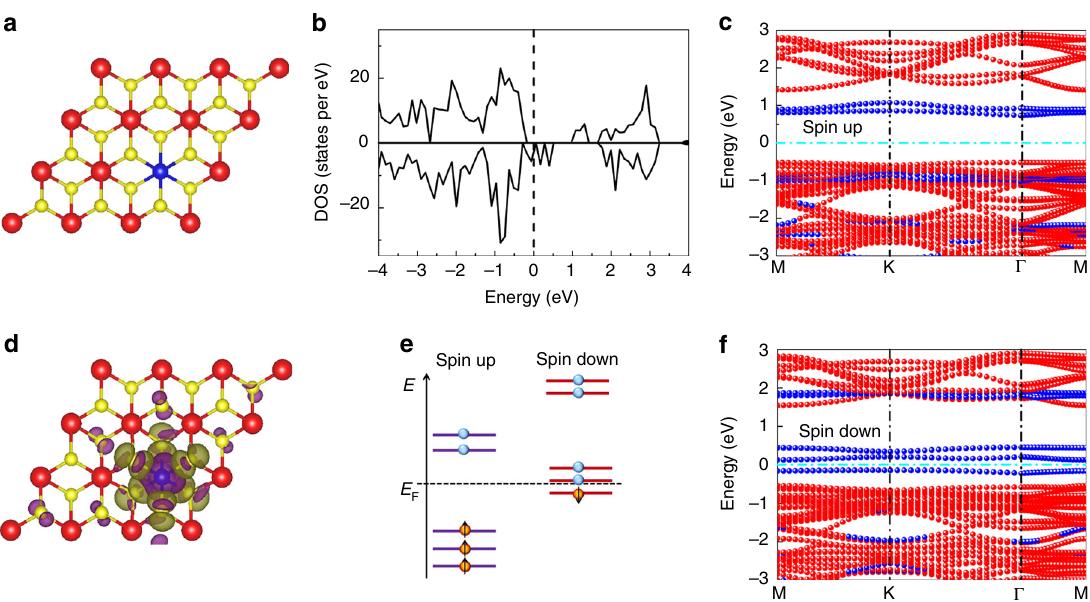
Fig. 4 Theoretical calculations of the Fe – SnS 2 monolayer. a Atomic structure of the Fe – SnS 2 monolayer. Red, yellow, and blue balls represent Sn, S, and Fe atoms, respectively. b Total density of states of the Fe – SnS 2 monolayer. c , f Projected band structures of the Fe – SnS 2 monolayer for up-spin and down-spin channels, respectively. Red and blue circles denote the contribution of Sn and Fe atoms in the total band structure, respectively. The Fermi level was set to zero. d The distribution of the spin density in real space for the Fe – SnS 2 monolayer is shown. The isosurface value was taken at 0.001 eÅ − 3 . e Schematic of the Fe 3 d electron arrangement with spin in Fe – SnS